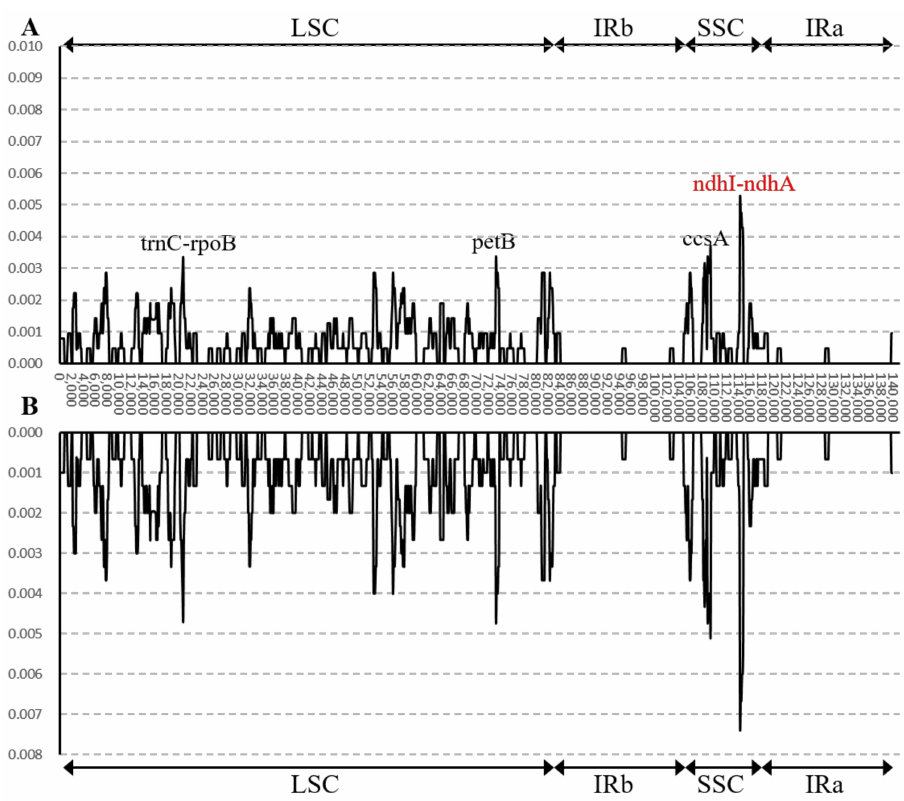
Figure 5. Chloroplast genomic analysis using sliding-window method. ( A ) All seven dwarf orna- mental bamboo species. ( B ) Five bamboo species, S. kongosanensis ‘Aureostriatus’, P. argenteostriatus , P. pygmaeus , S. glabra and S. glabra ‘Albostriata’. Window length: 600 bp; step size: 100 bp; X -axis: